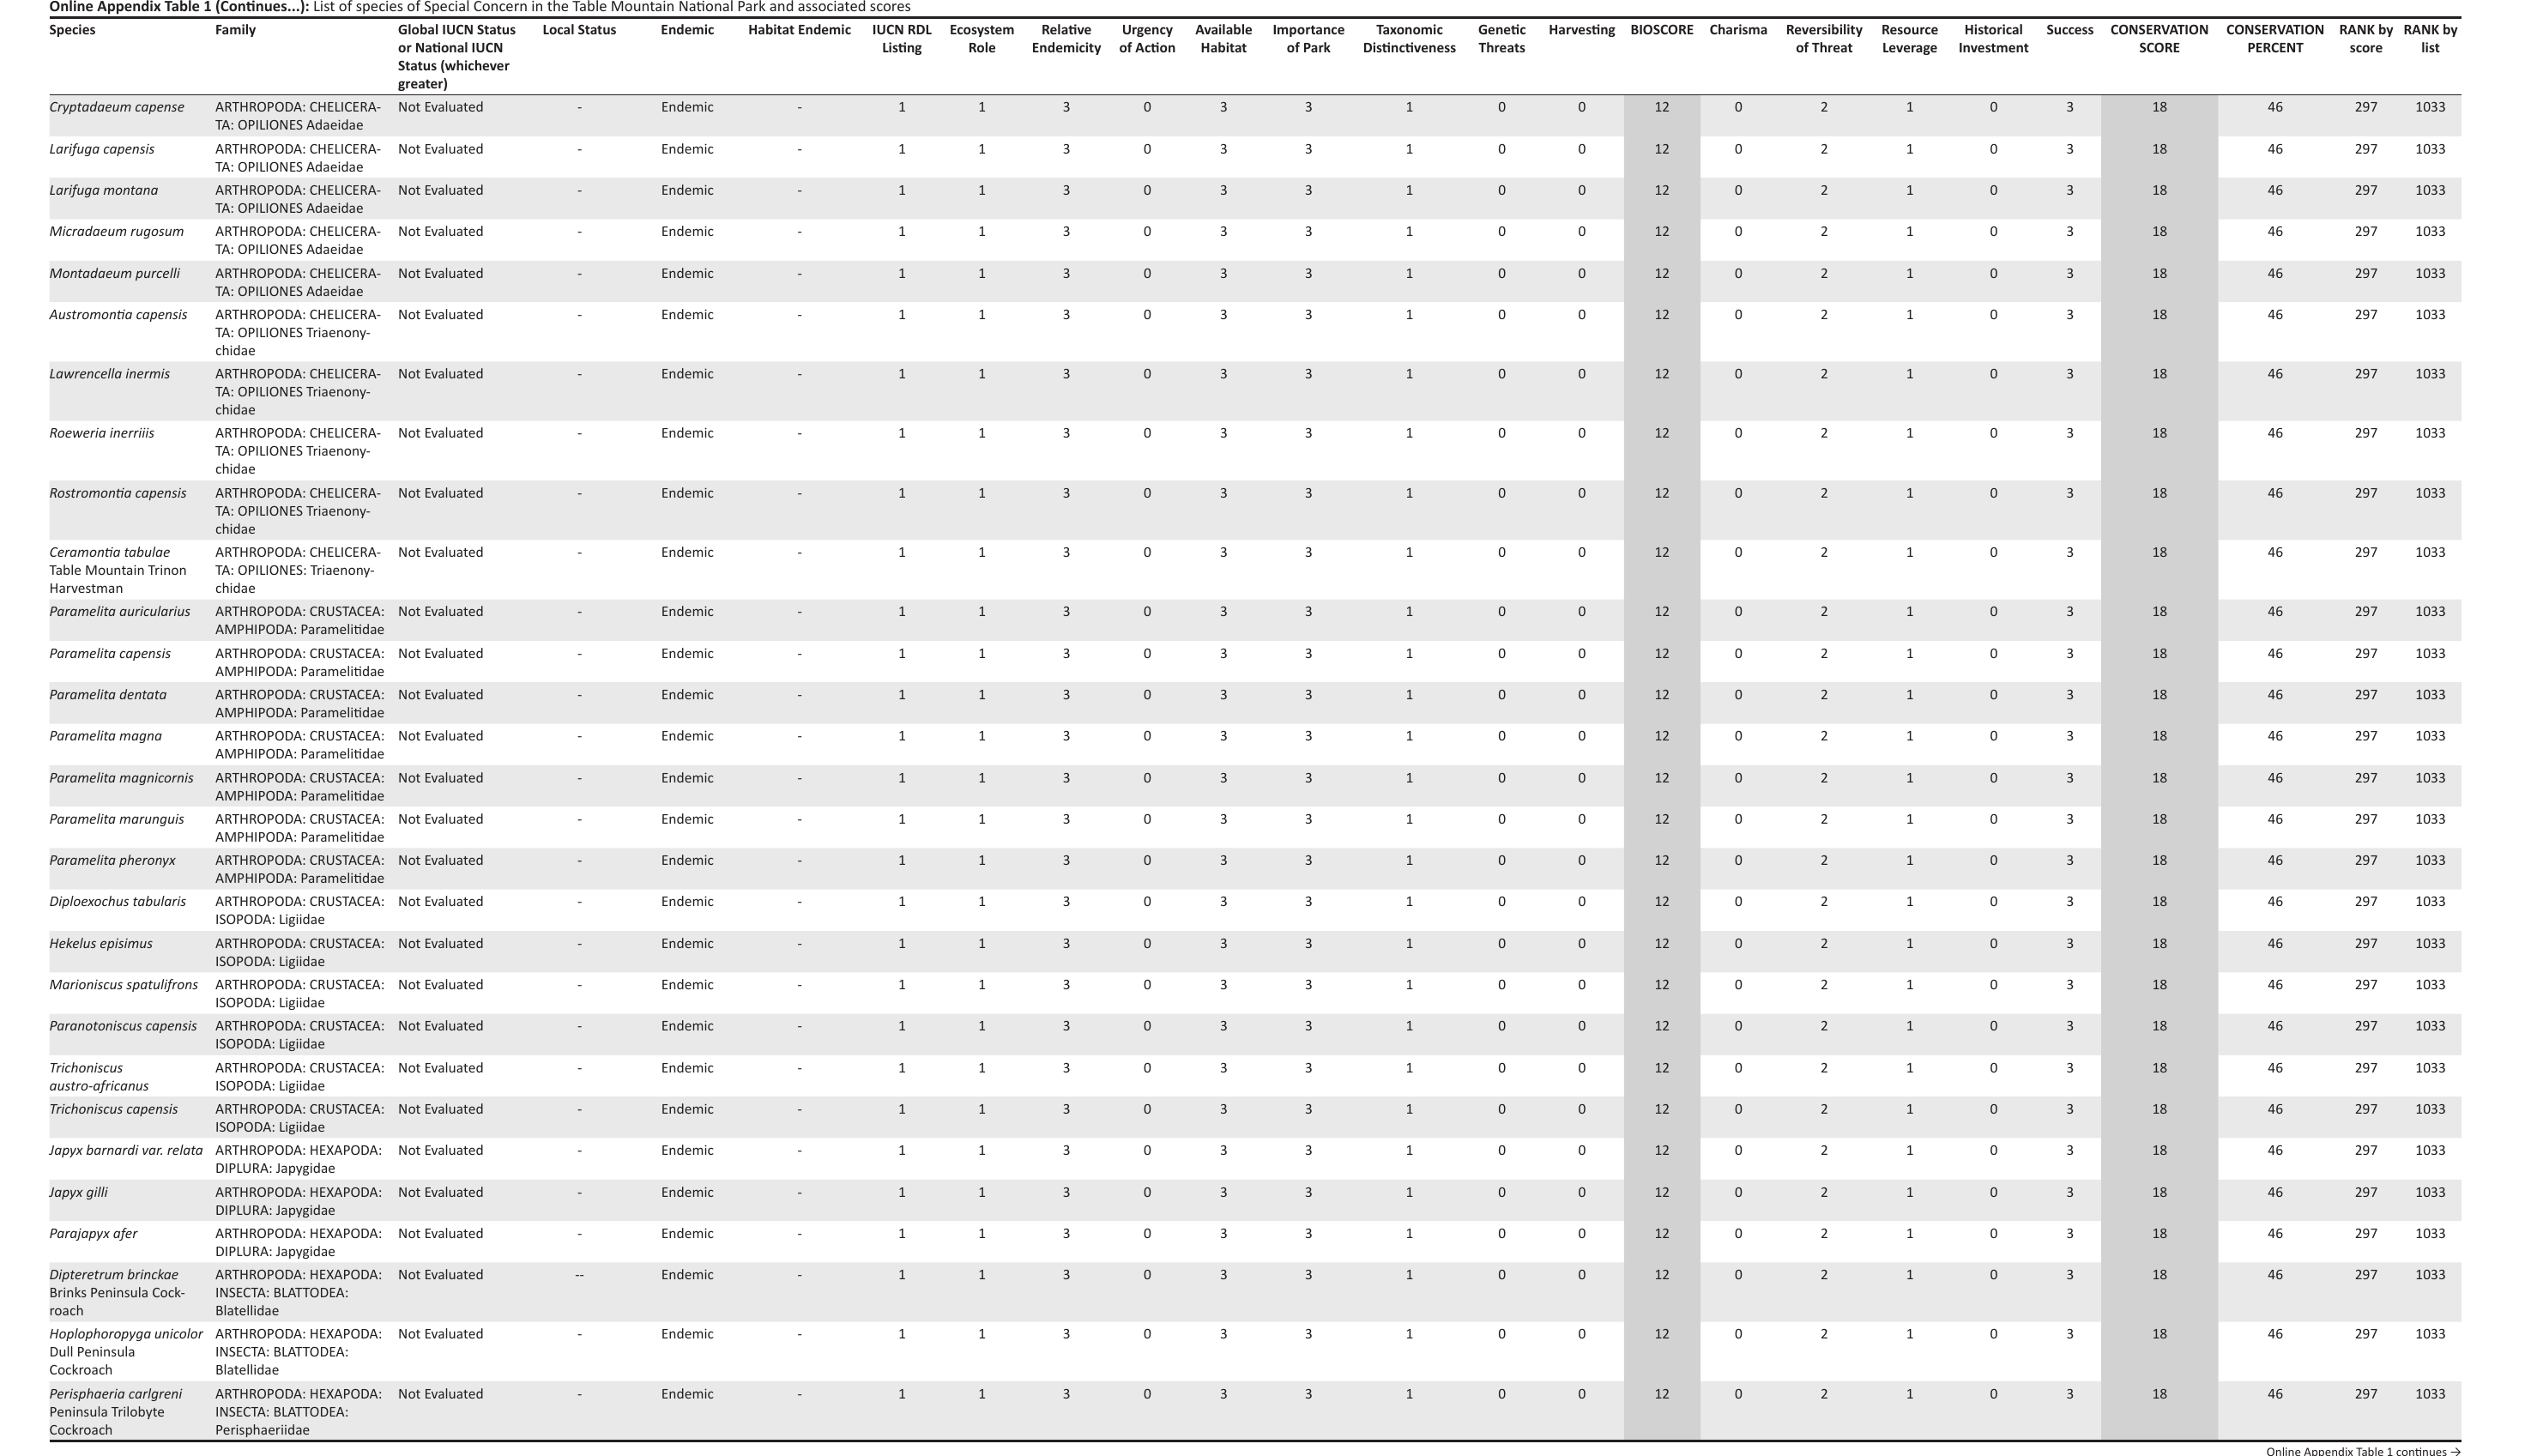
Online Appendix Table 1 (Continues...): List of species of Special Concern in the Table Mountain National Park and associated